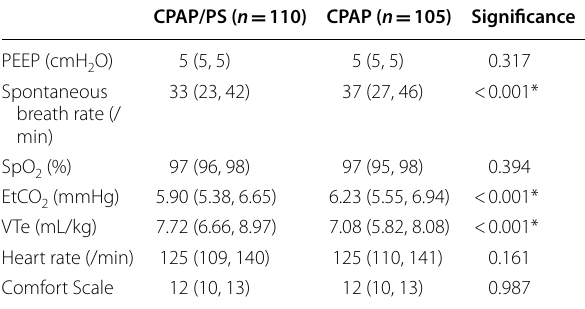
Table 2 Summary of haemodynamic and